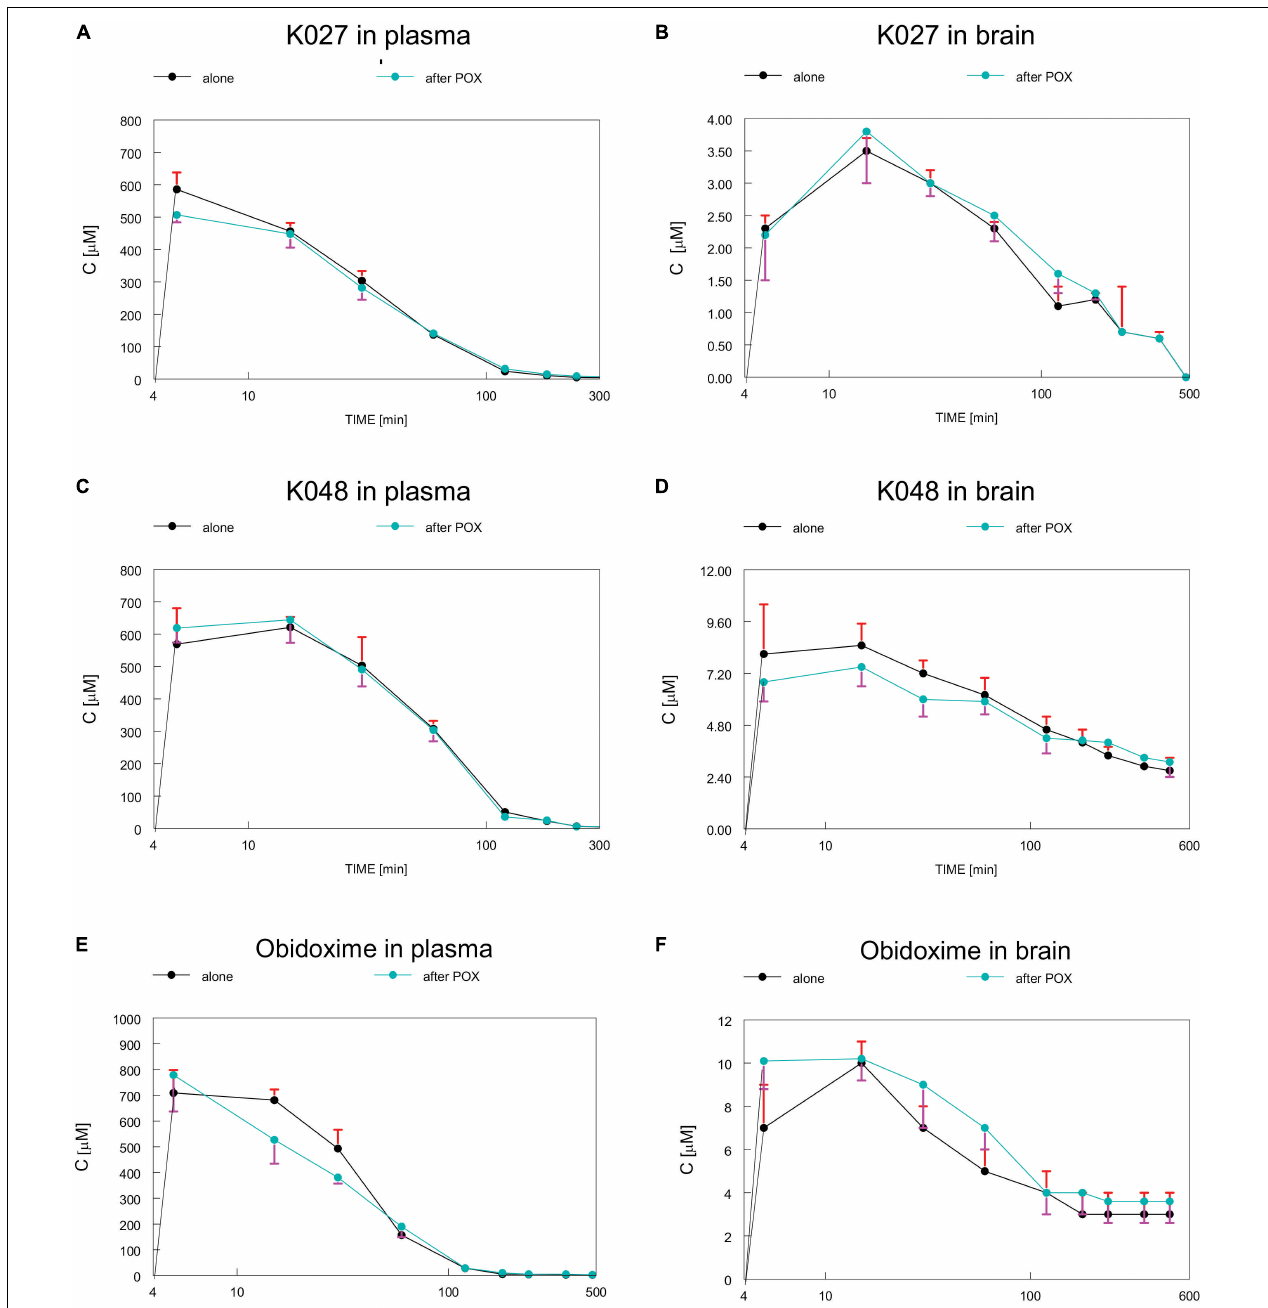
FIGURE 2 | Time course of concentrations of experimental K-oximes K027 (A,B) and K048 (C,D) and the established oxime obidoxime (E,F) in plasma (A,C,E) and brain (B,D,F) after intramuscular (i.m.) injections of 50 µ mol of oxime into rats. Depicted are concentrations, when oxime was injected alone (black) or in combination with paraoxon (POX, blue), which did not significantly influence plasma or brain concentrations of K027, K048, or obidoxime. Data from Lorke et al. (2007) and Petroianu et al. (2007b). Image reproduced with permission of “JOHN WILEY AND SONS,” License Number: 4450270092893.